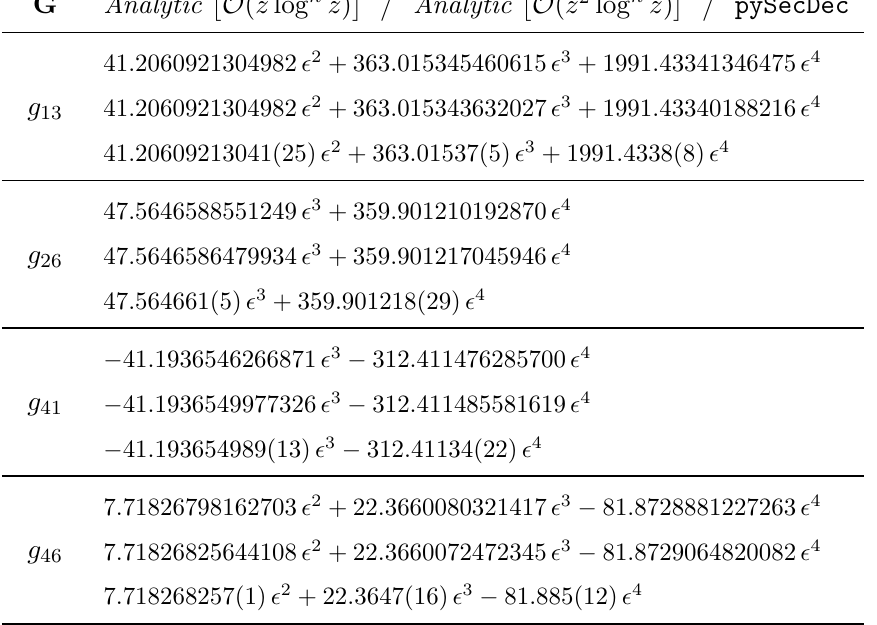
Table 1. Comparison between the numerical results obtained from our analytic expressions and pySecDec for g 13 , g 26 , g 41 and g 46 at ( s, t, m 2